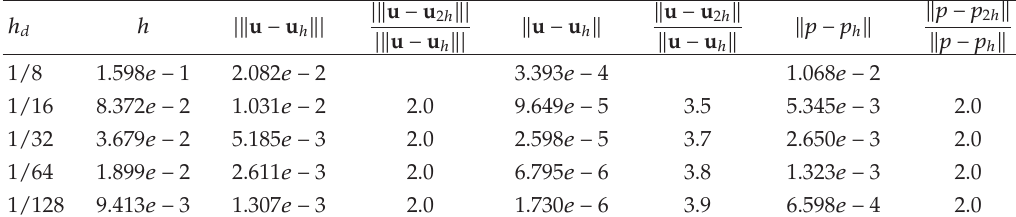
Table 1: Error behavior for scheme (cid:4) 2.27 (cid:6) .